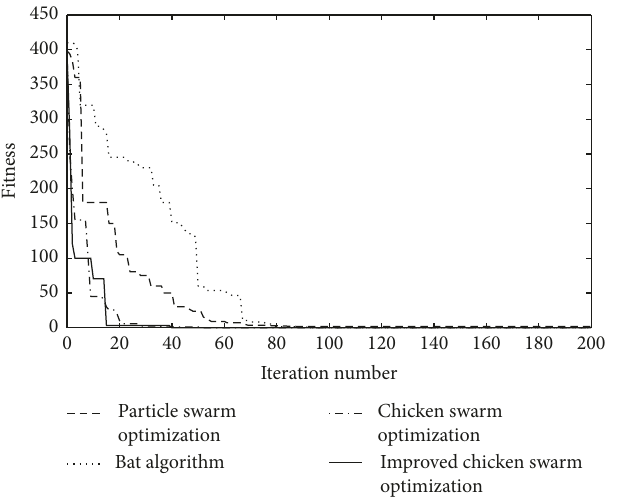
Figure 5: The experimental result of f